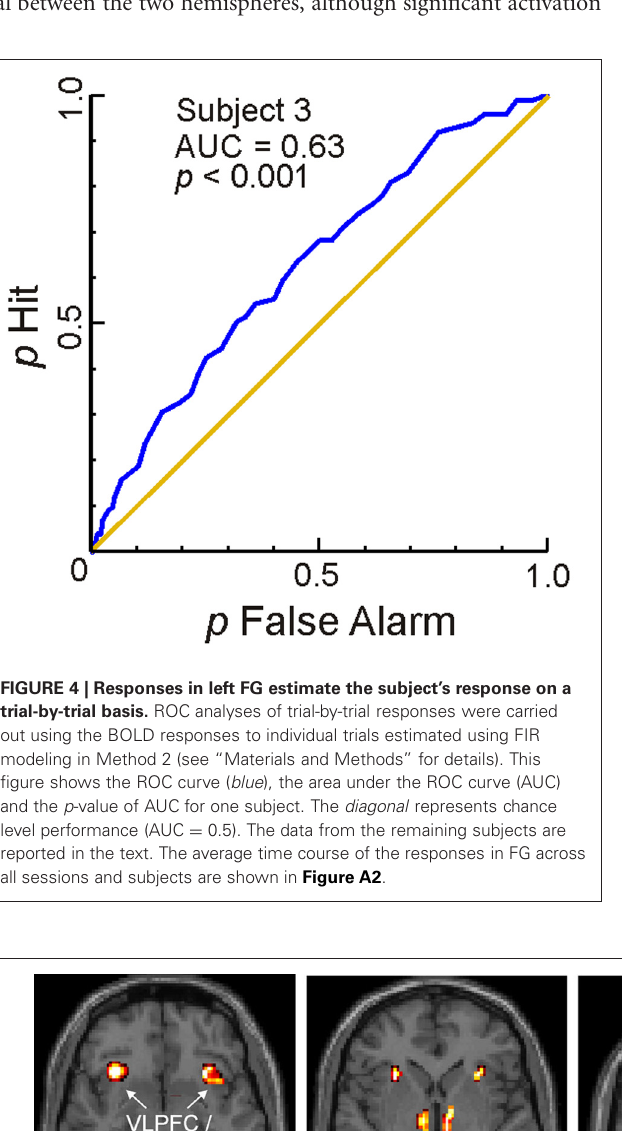
that were significantly activated in both statistical maps by a conjunction analysis ( p < 0 . 05). Activations are shown superimposed on axial slices of a standard individual brain template. Abbreviations: IOG, inferior occipital gyrus; IPS, intraparietal sulcus; LOC, lateral occipital complex; VLPFC, ventrolateral prefrontal